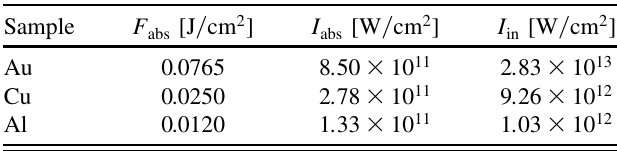
TABLE II. Required absorbed laser fluences F the surfaces of the different materials. The values are chosen to be 10% below the melting threshold. The absorbed intensities I and the corresponding incoming intensities I abs for the 90 fs Callisto laser beam assuming reflectance values of R ¼ 0 : 87 for aluminum and R ¼ 0 : 97 for copper and gold. Sample